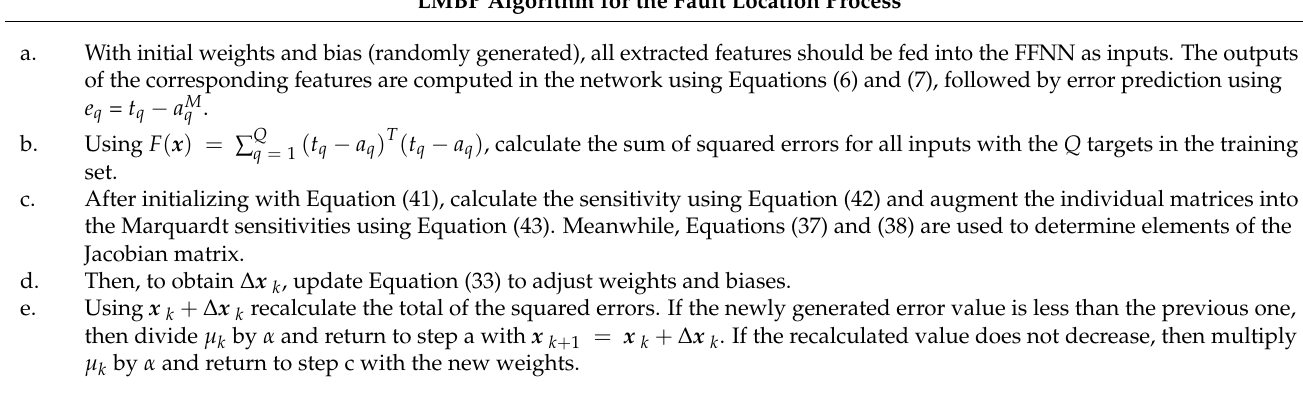
LMBP Algorithm for the Fault Location